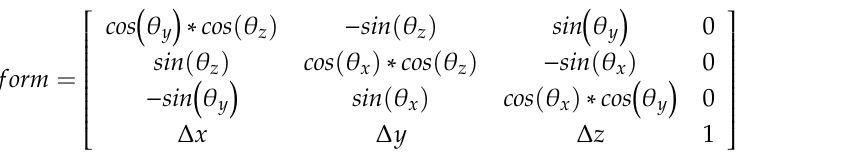
Figure 8. ( a ) Normal Point Cloud; ( b ) Downsampled Point Cloud.